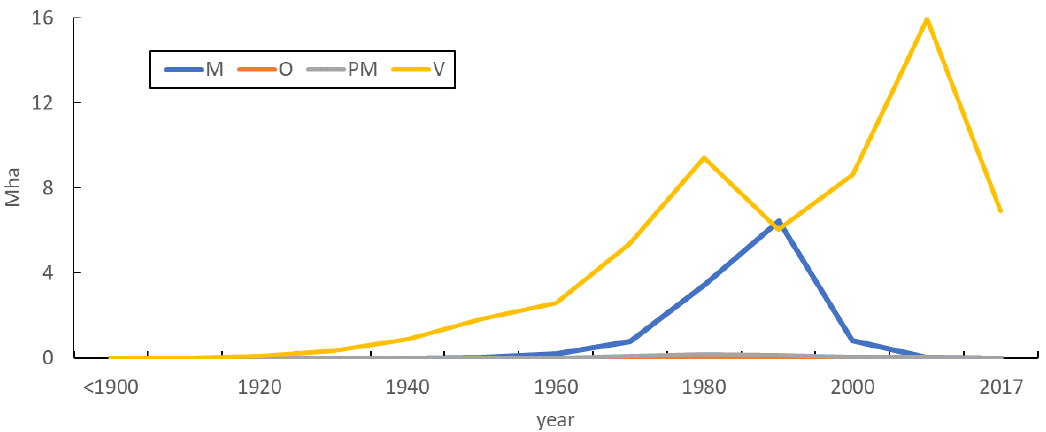
Figure 4. Time period of plantation (x-axis) and surface area in the Valencian community (y-axis, in mega hectares) by final wine product.